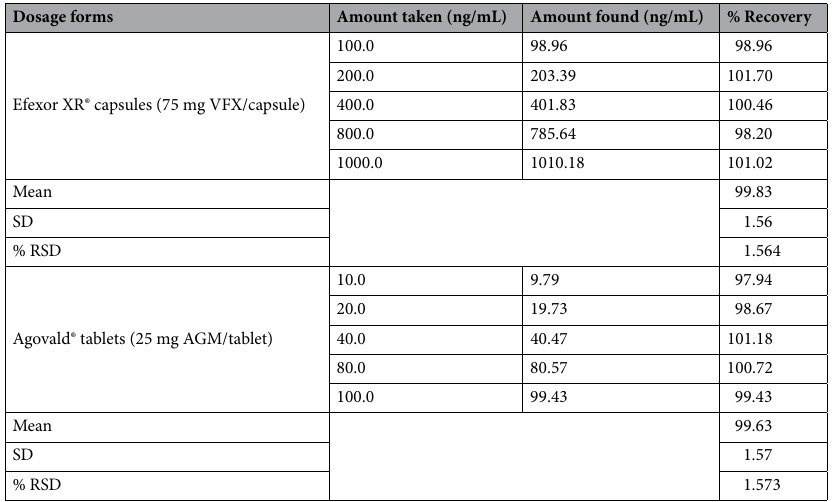
Table 4. Determination of VFX and AGM in pharmaceutical dosage forms using the proposed method. N.B. Each result is the average of three separate determinations.